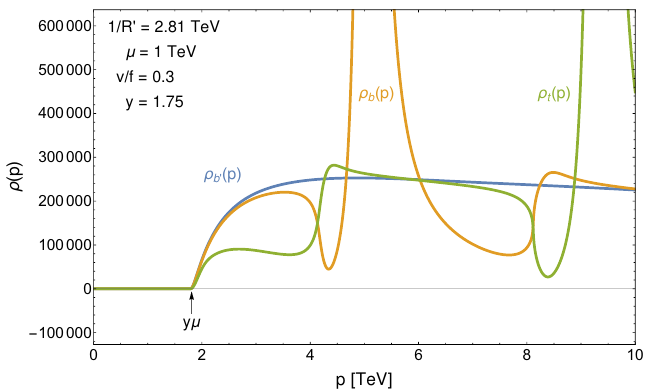
Figure 6 . Top, bottom and b 0 spectral densities for v=f = 0 : 3 and parameter values from the BP in eq. (5.1). The spectral function features broad peaks that could be probed at a future 100 TeV